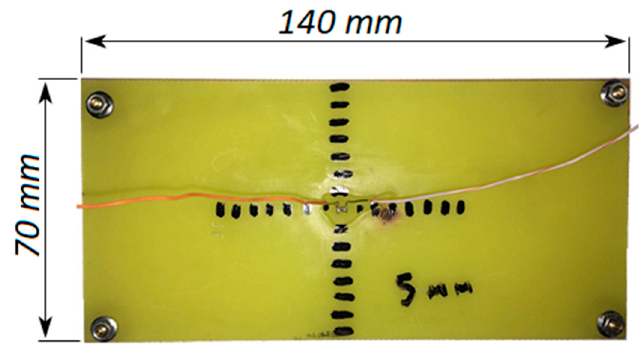
Figure 2. Experimental model.